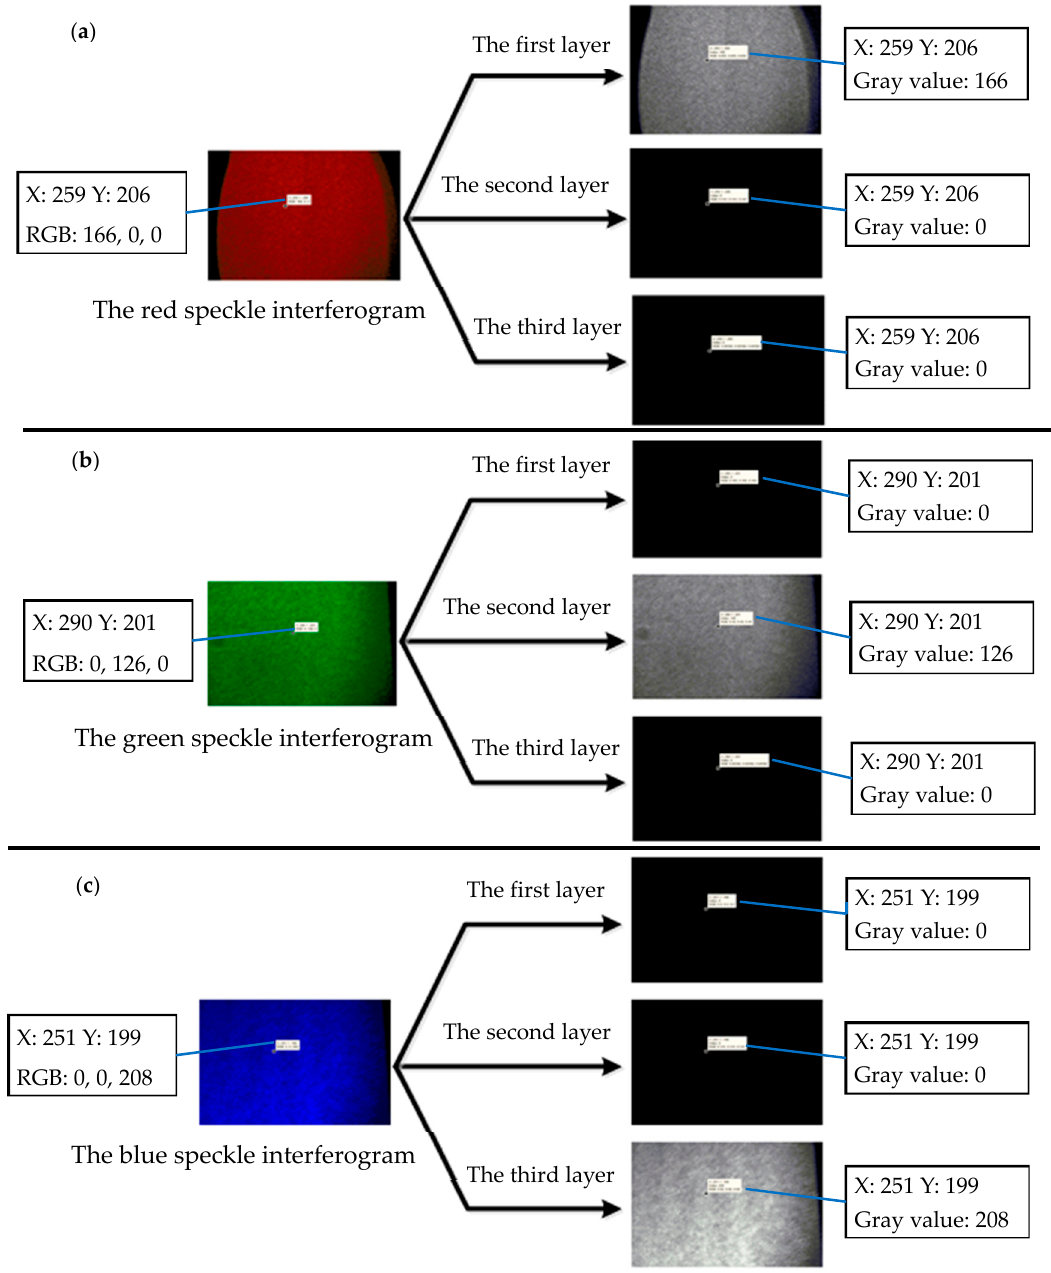
Figure 6. The speckle interferograms and grey-scale maps. ( a ) The red speckle interferogram; ( b ) The green speckle interferogram; ( c ) The blue speckle interferogram.